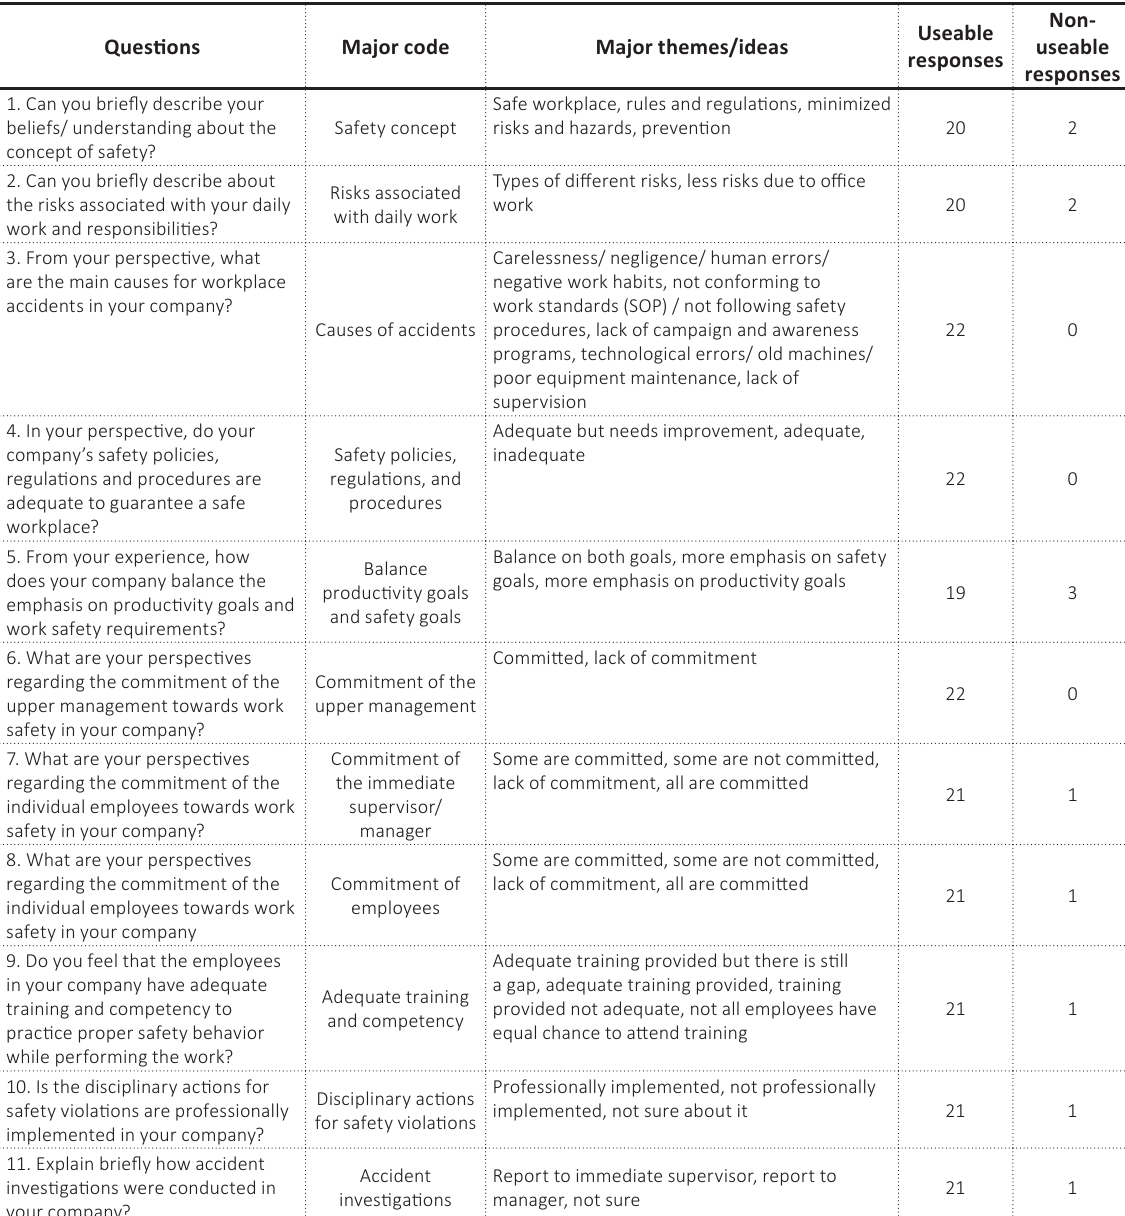
Table 1. Results of thematic content